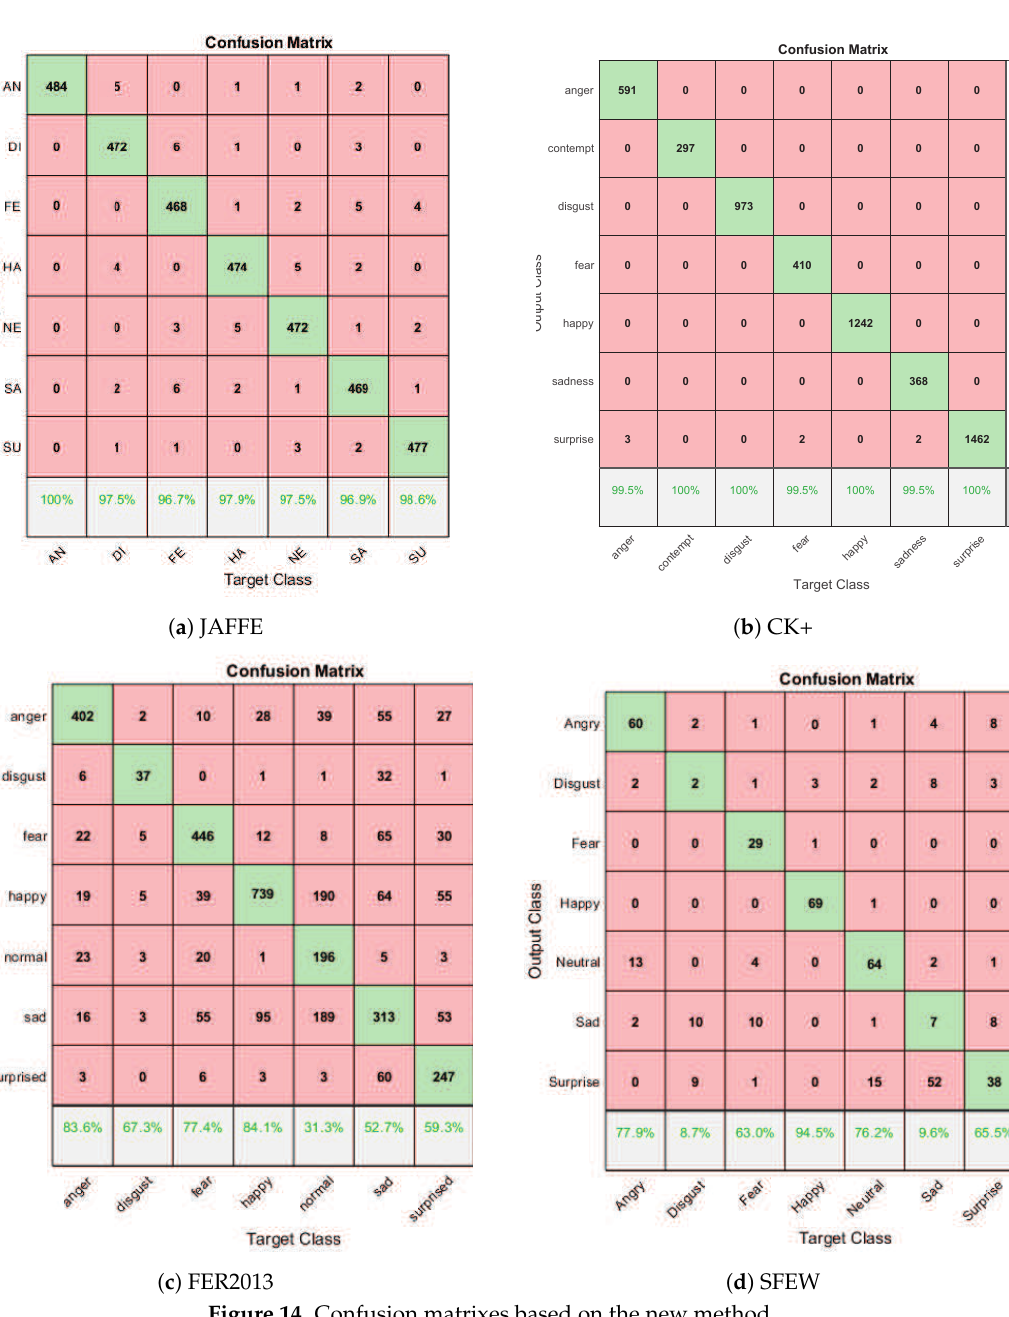
Figure 14. Confusion matrixes based on the new